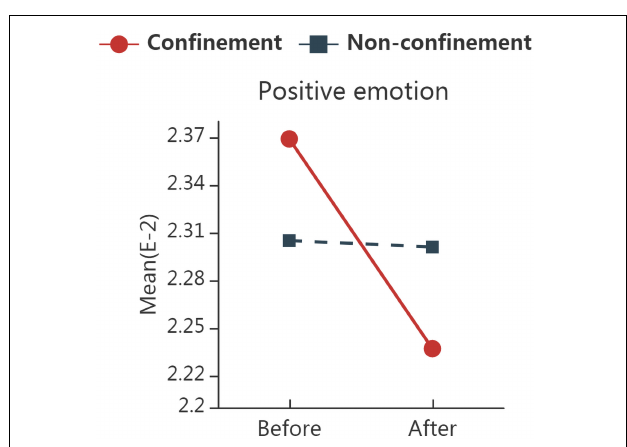
FIGURE 3 | The interaction plots for words with significant interactions in low-endemic subgroup. Significant group (confinement vs. non-confinement) * time (before vs. after confinement) interaction was found in the frequency of positive emotion words by RM ANOVA. “Confinement” represents samples in all 14 cities where home confinement have implemented; “Non-confinement” represents samples that have not experienced home confinement; “Before” represents the data collected from 2 weeks before home confinement, and “After” represents that from 2 weeks